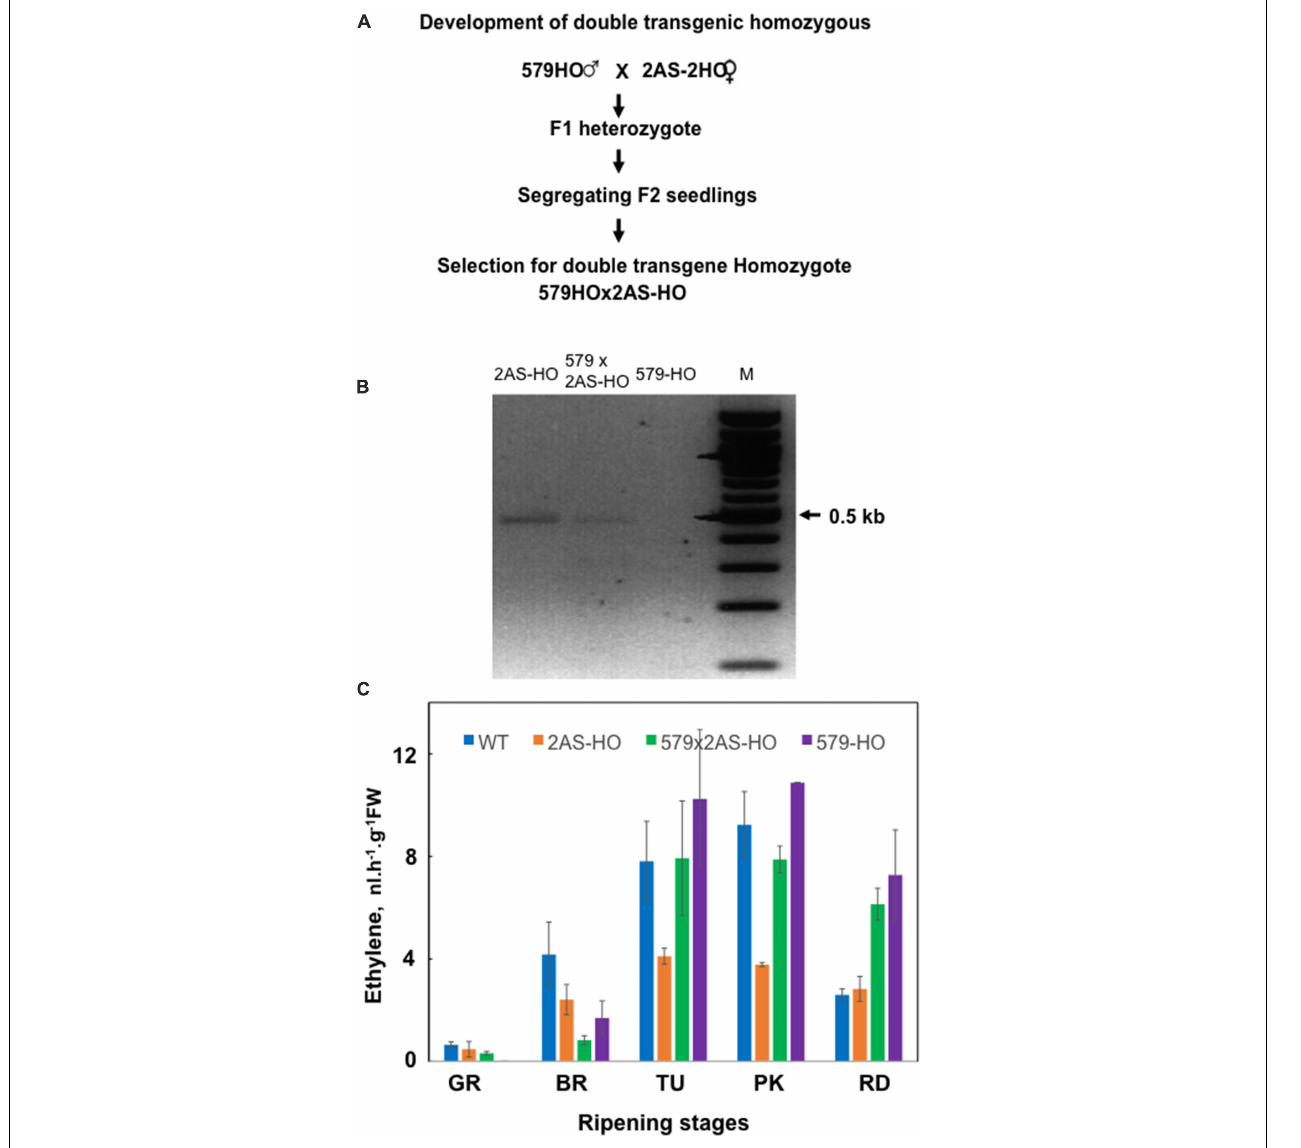
homozygous lines. (B) RT-PCR of RNA from 2AS-AS (labeled 2AS-OH) and double transgene homozygous 2AS-AS × 579HO (labeled 579 × 2AS-HO) showing the expression of ACS2-AS transcript. Shown is the 0.5 kb PCR fragment from ACS2 gene. The line 579HO does not harbor ACS2-AS transcript and is therefore negative for its RNA. (C) Rate of ethylene evolution by fruits of wild type (WT), 2AS-AS antisense line (2AS-OH), 2AS-AS × 579HO (579 × 2AS-HO) and 579-HO at various stages of ripening. Each time point represents the means + SE from a minimum of three fruits except for the pink (PK) fruits from 579HO line where only two fruits were